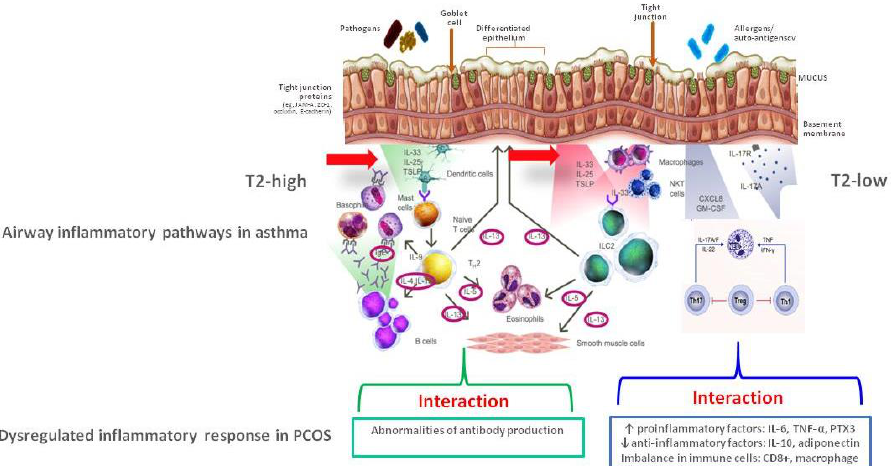
Figure 2. Potential interaction between molecular mechanisms behind polycystic ovary syndrome and airway inflammation in asthma. (PCOS = polycystic ovary syndrome; PTX3 = pentraxin 3). 3. The Therapeutic Role of Myo-Inositol in Patients with “Asthma-PCOS Overlap